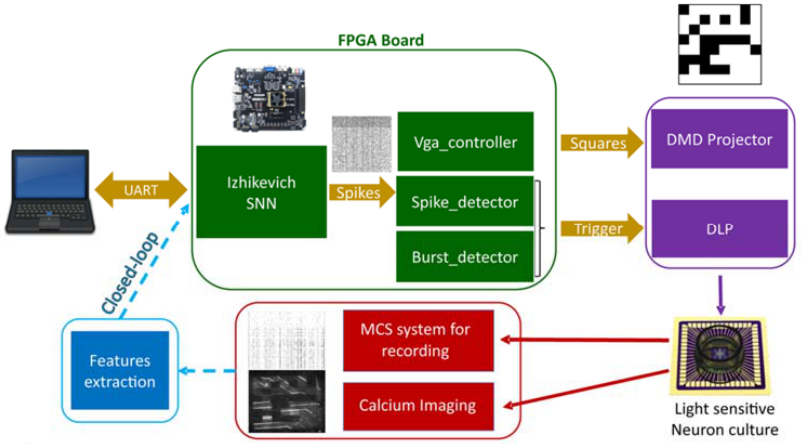
Figure 3. Scheme of the experimental set-up. An Izhikevich SNN is implemented into FPGA board. Spikes outputs are converted into 8 × 8 images through vga to a Digital Micromirror Device projector (DMD) organized around an upright microscope where a biological neuronal network cultured on a multi-electrode array is placed. Neuronal activities are recorded by both electrical signals (MCS system) and optical signals (Calcium imaging). The next step is to close the loop, adding feature extraction from biological activity to feed in the SNN to achieve a real-time bi-directional communication. Adapted from [78].